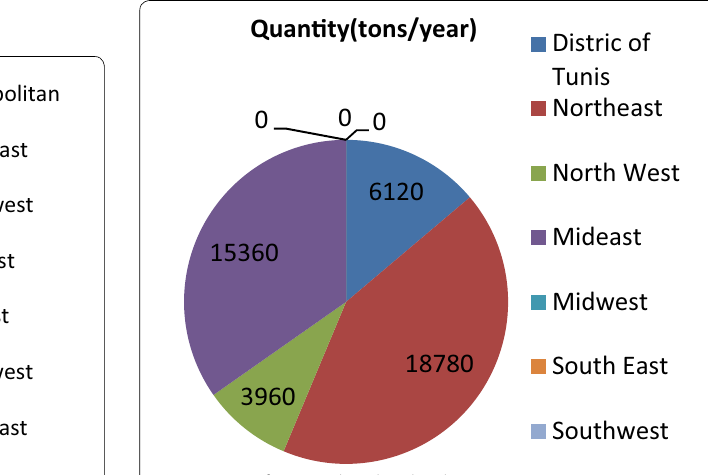
Fig. 6 Wastes from livestock slaughterhouses Fig. 7 Waste from poultry